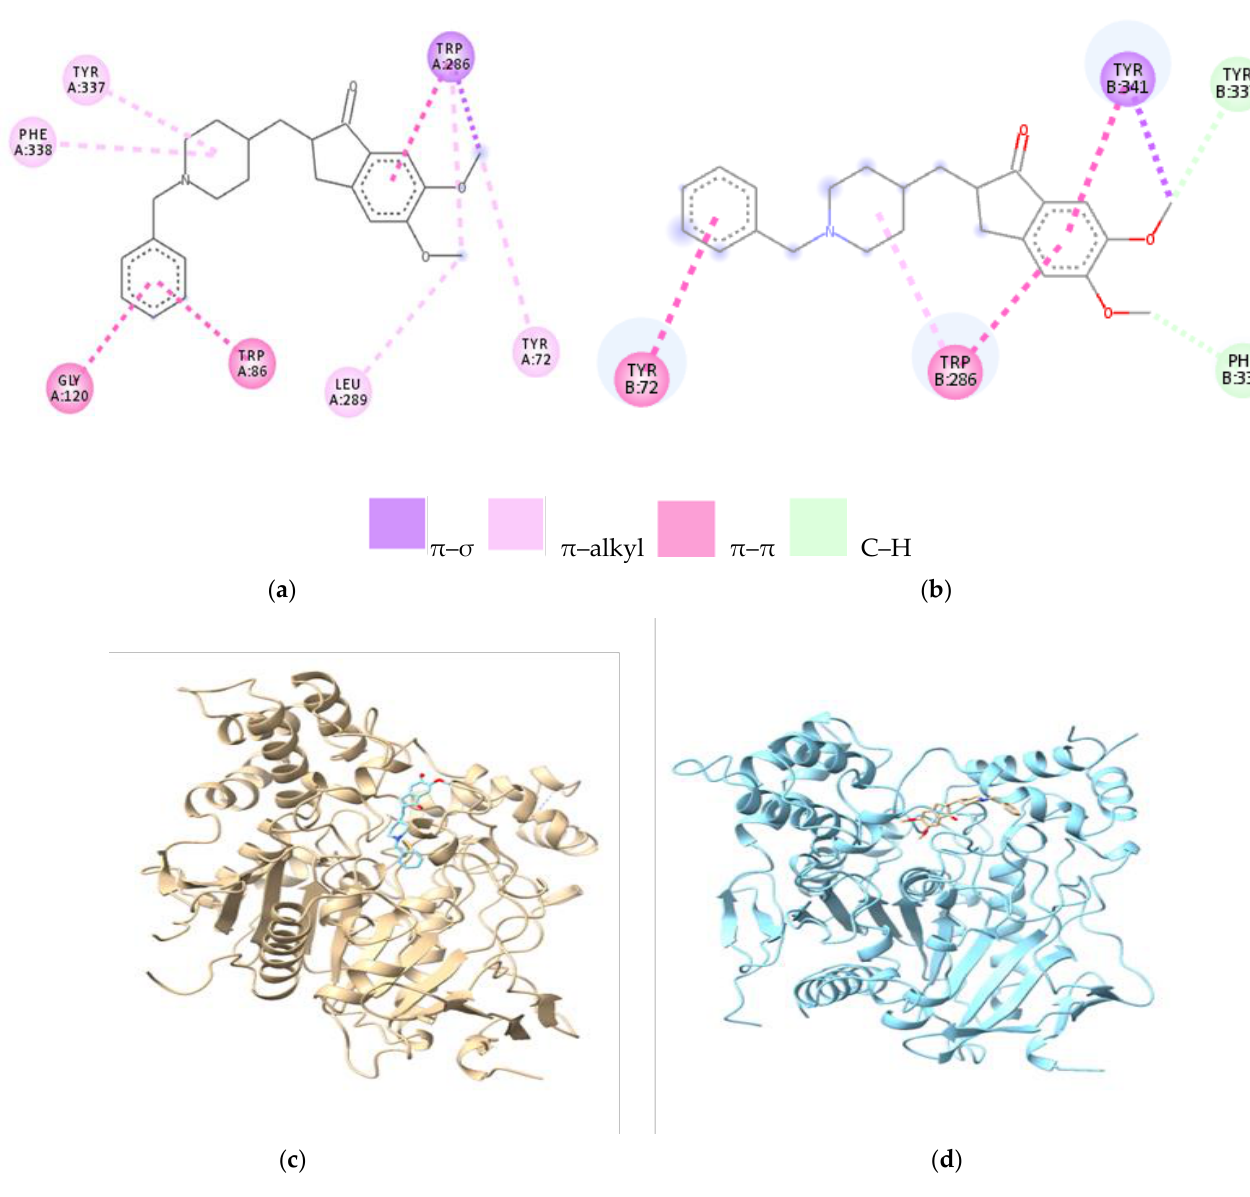
Figure 2. 2D and 3D representation of the ligand – protein complex; ( a ) donepezil – AChE (A chain) complex; ( b ) donepezil – AChE (B chain) complex; ( c ) 3D structure of donepezil – AChE (chain A) complex; ( d ) 3D of donepezil – AChE (chain B) complex. Legend: GLY — glycine; TYR — tyrosine; TRP — tryptophan; PHE — phenylalanine; LEU — leucine. The letters A and B represent the chain; the number represents the numbering of the amino acid.